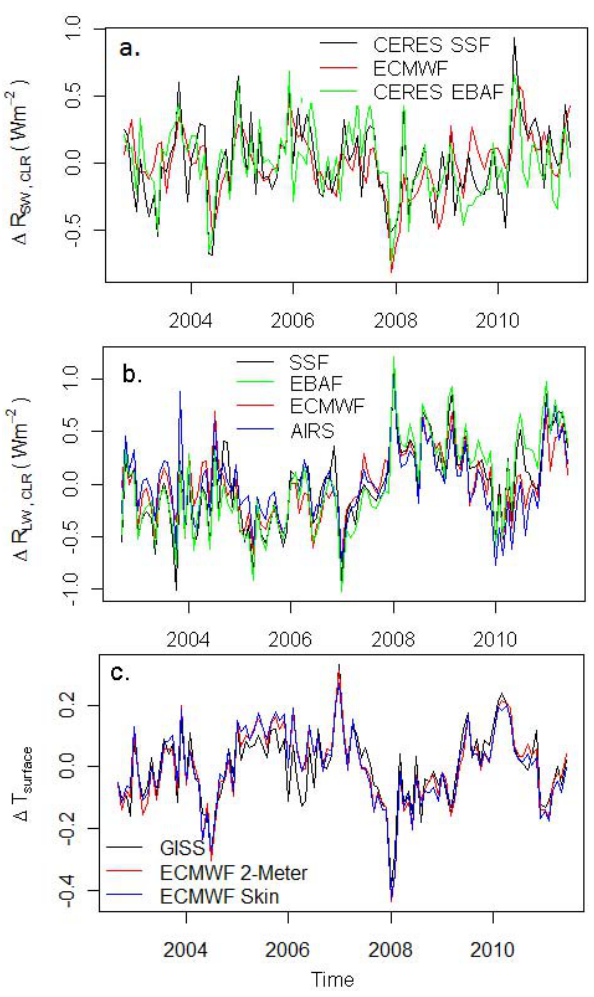
Fig. 2. (a) Global monthly anomalies for shortwave, clear-sky TOA radiative flux from CERES (Terra+Aqua SSF1 degree), ECMWF ERA-Interim, and CERES EBAF. (b) Global monthly anoma- lies for longwave, clear-sky TOA radiative fluxes from CERES (Terra+Aqua SSF1 degree), ECMWF ERA-Interim, AIRS, and CERES EBAF. (c) Surface temperature anomalies from GISS, ECMWF ERA-Interim 2-m and skin